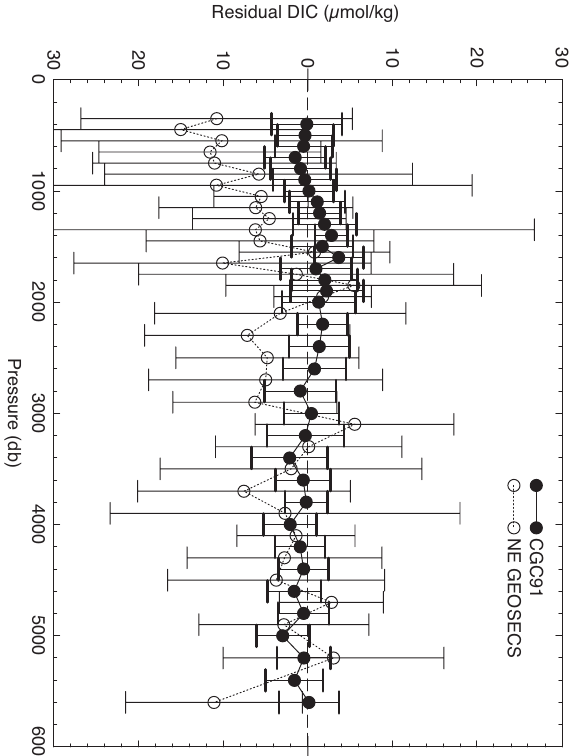
F IG . 4. – The distribution of residual DIC after all samples are binned into 100 m layers over the upper 2000 m depth and into 200 m layers below 2000 m depth. The solid circles with heavy error bars are from CGC91, open circles with lighter error bars are from GEOSECS stations in the Northeastern